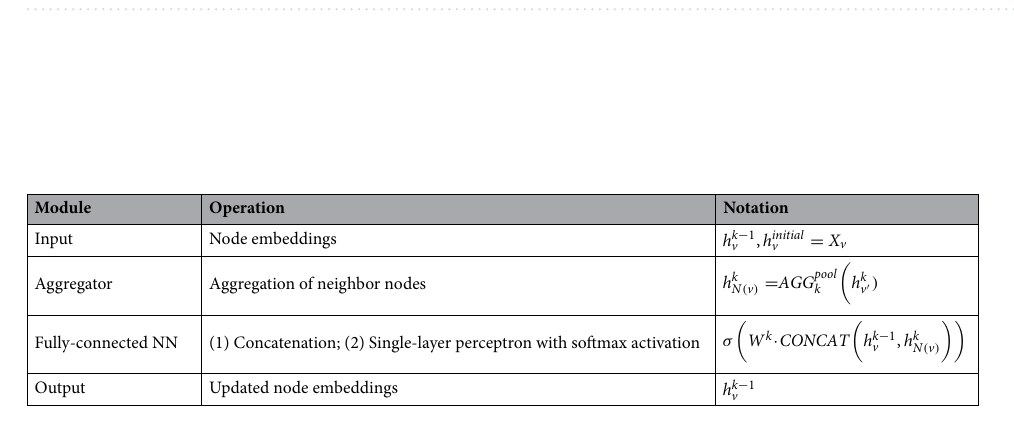
Table 2. The architecture of updating node embeddings for nodes in the ( k − 1 ) th ( ∀ k − 1 ∈ 1, . . . , K ) hop.